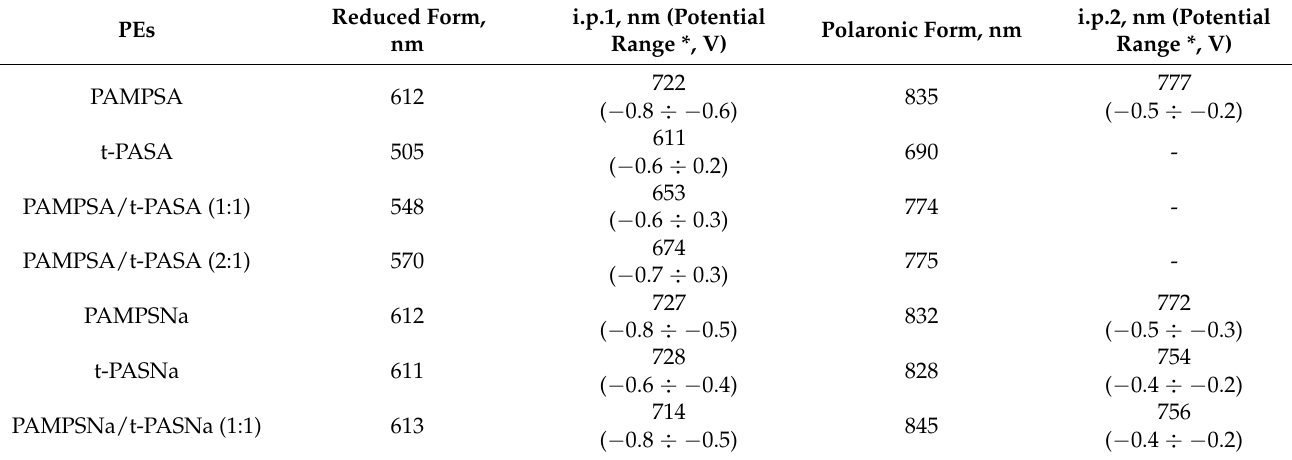
Table 2. The positions of the maxima of the absorption bands of the reduced and polaronic forms of PEDOT and the isosbestic points i.p.1 (neutral-to-polaron) and i.p.2